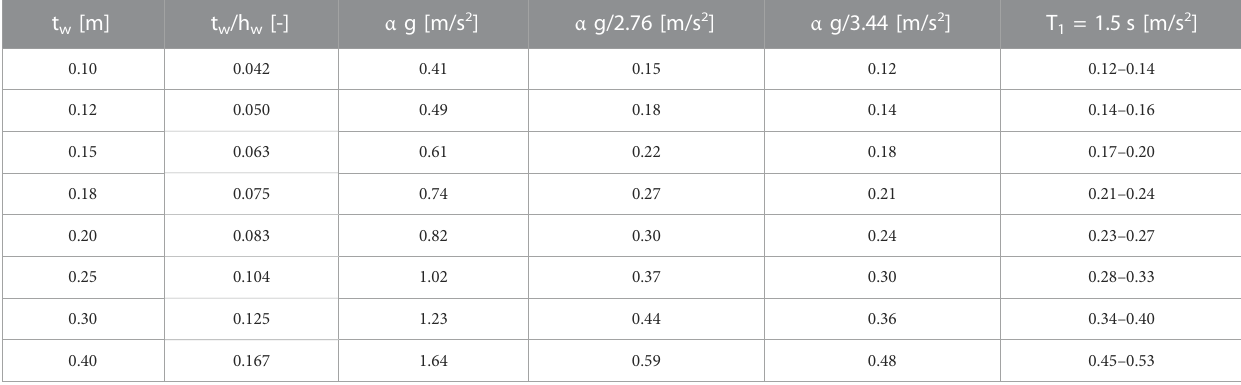
TABLE 7 Results for a wall height of 2.4 m located in the upper fl oors in case of soil class C and a period of the primary structure of T 1 = 1.5 s. The considered ultimate ground accelerations for damping ratio between 3% and 5% (last column) compare well with the reduced static stability condition.